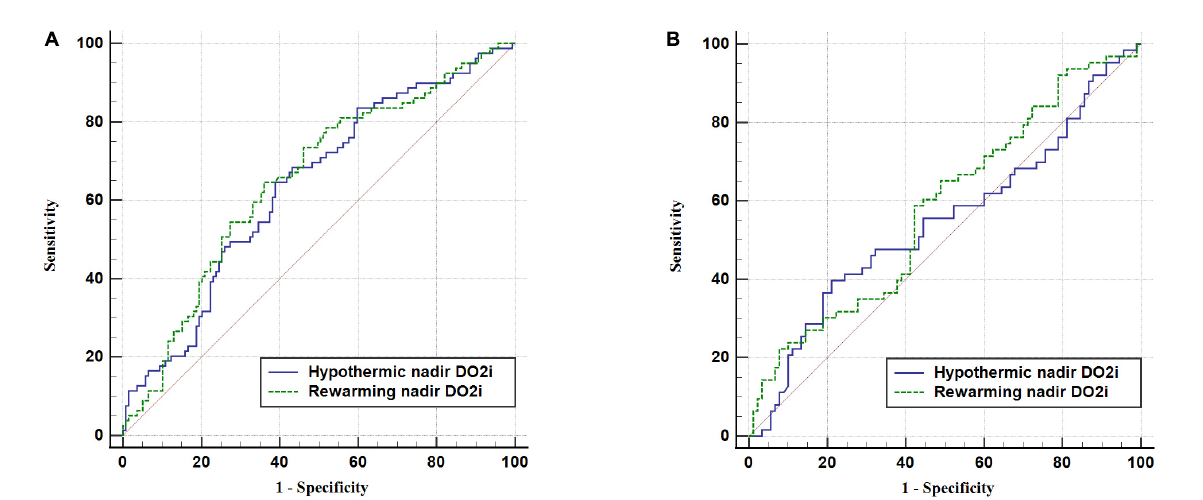
FIGURE3 Receiver operating characteristic (ROC) curve of nadir DO 2 i in hypothermic and rewarming phases for postoperative AKI. (A) Patients undergoing mild hypothermia during CPB. (B) Patients undergoing moderate hypothermia during CPB.